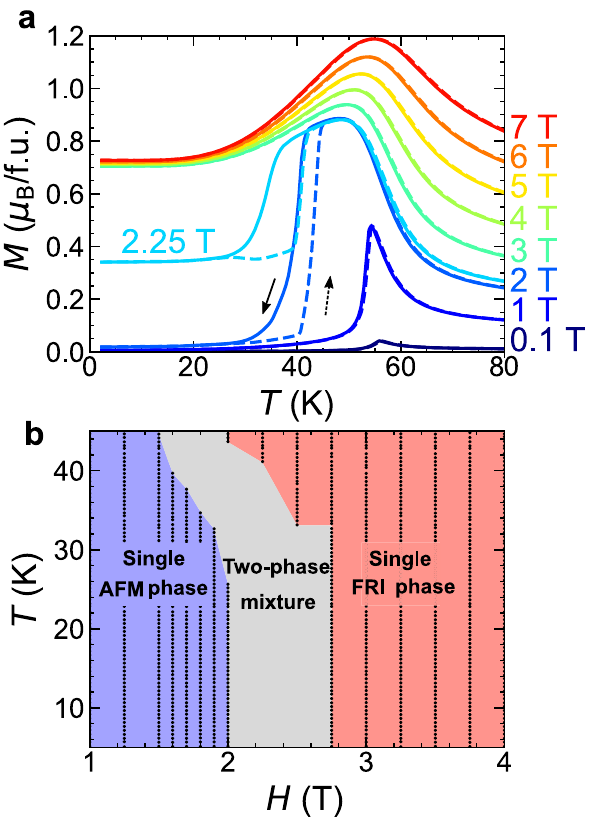
Figure 2. Identification of single-phase AFM and FRI phases from M − T curves. ( a ) Temperature dependencies of the magnetization upon field-cooling (FC; solid lines) and field-warming (FW; dashed lines) processes. ( b ) Schematic phase diagram highlighting the single thermodynamic AFM and FRI phases. The black dots represent data points used for the present analysis while carefully avoiding the “two-phase mixture” (gray)